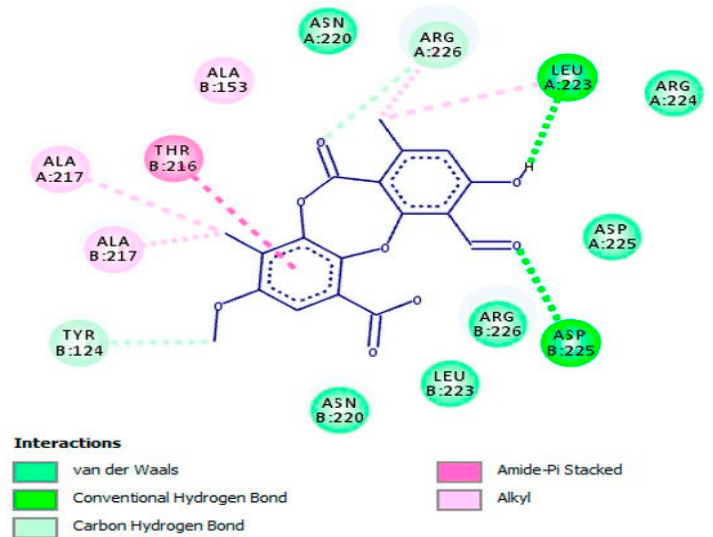
Figure 8. Molecular interaction of psoromic acid (PA, 45 ) with the active site of HSV-2 protease. Amino acid residues involved in HSV-2 protease stabilization along with the hydrogen bonding and other essential interactions for enzyme inactivation are illustrated. Significant functional groups of PA that account for the inhibitory action against HSV-2 protease are presented. This figure and its description have been adapted from Hassan et al. [46] with permission, as the article has been published by an MDPI publisher and licensed under an open access Creative Commons CC BY 4.0 license.